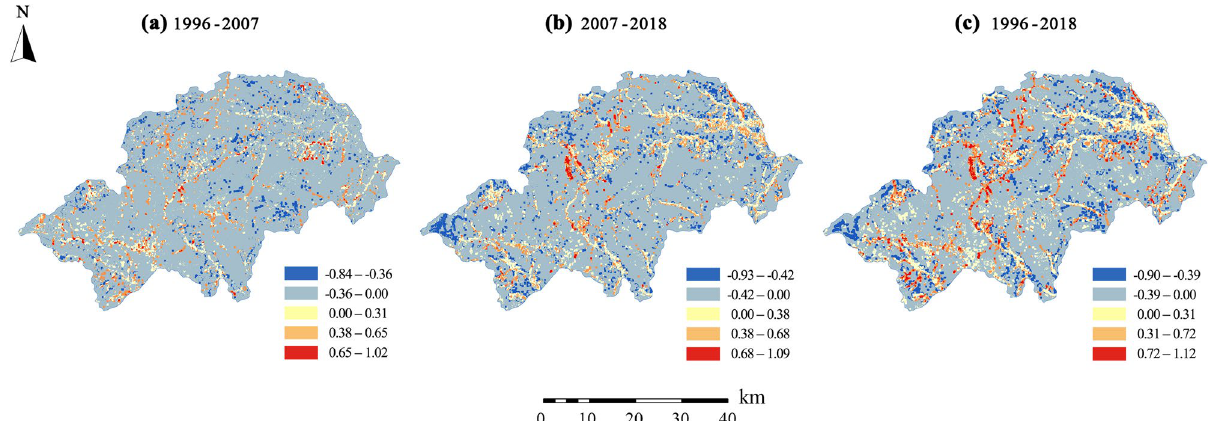
Figure 5. Dynamic changes of ecological vulnerability in Shennongjia. Changes in the ecological vulnerability of Shennongjia in different periods: ( a ) 1996–2007, ( b ) 2007–2018, ( c )